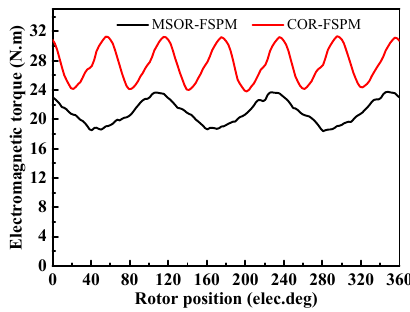
Figure 19. Electromagnetic torque waveforms of the MSOR-FSPM motor and COR-FSPM motor.